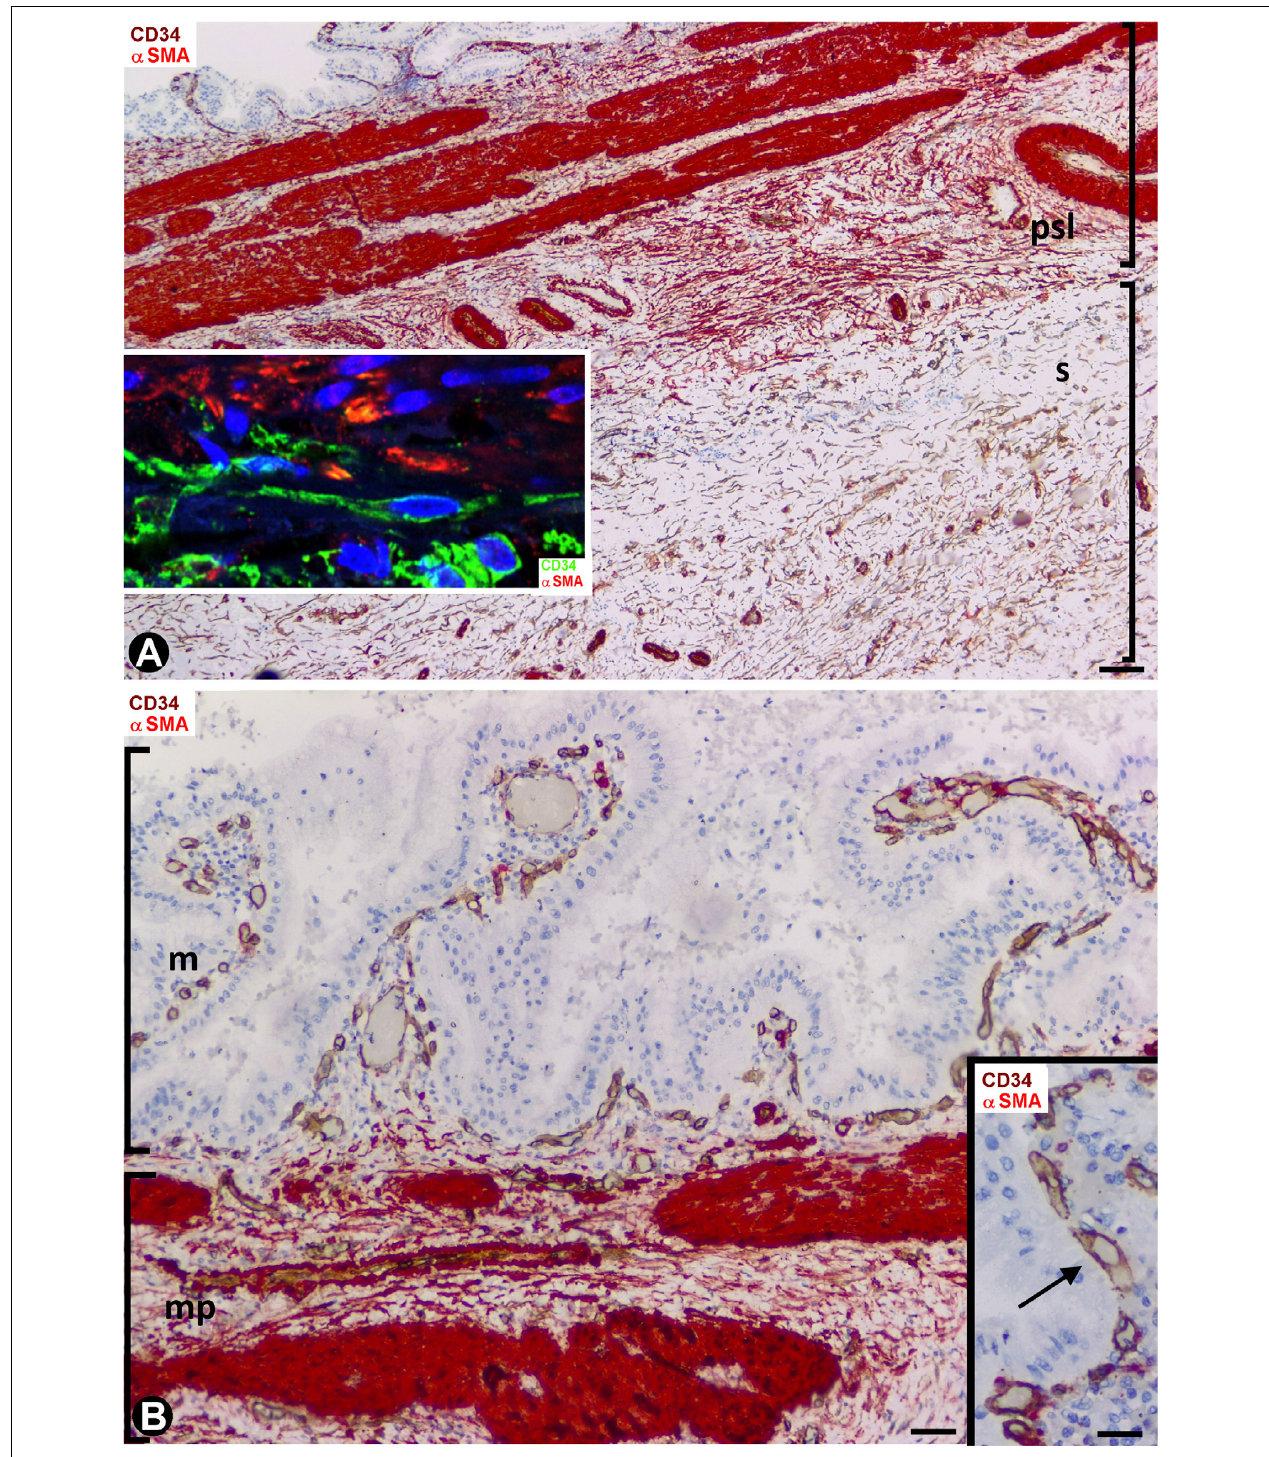
FIGURE 2 | Stromal cells during repair in acute cholecystitis. Double staining with anti-CD34 (brown) and anti- α SMA (red). (A) Panoramic view of the gallbladder wall showing a high α SMA expression (deep red) in smooth muscle cells of the lamina propria and of vascular media layer, and moderate expression in myofibroblasts (numerous in the perimuscular serosal layer: psl). Note persistence of CD34+SCs/TCs (brown) in the area of serosa underlying the perimuscular serosa layer. In the insert, a zone of transition between α SMA+ cells (myofibroblasts, red) and CD34+SCs/TCs (green) is shown by fluorescent immunostaining in confocal microscopy. (B) Absence of activated stromal cells in the mucosa, whereas α SMA+ activated stromal cells (red) are present between the muscle fascicles (deep red) of the muscularis propria. In the insert, detail of the vessels (arrows) in the mucosa. Bar: (A) 60 µ m, (B) 40 µ m; Insert: 20 µ m.